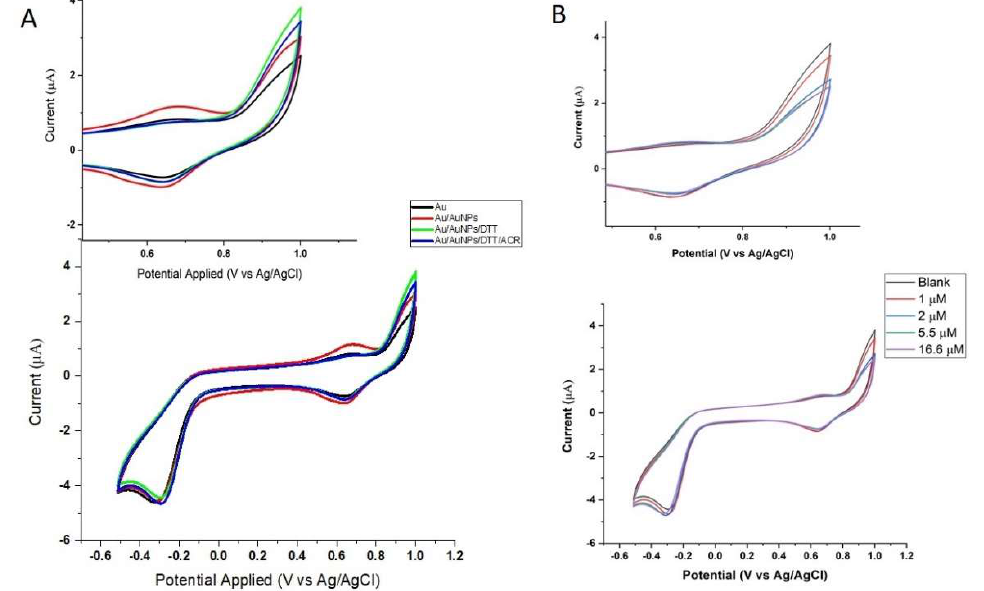
Figure 1. ( A ) CV analysis of bare gold, AuNP-modified Au electrode, and DTT-AuNP modified Au electrode and the addition of ACR of the AuNP-DTT modified gold electrode. ( B ) The effect of different concentrations of ACR on the modified electrode; Blank (AuNP-modified Au electrode without analyte). The observed current decreased with increasing ACR concentrations.